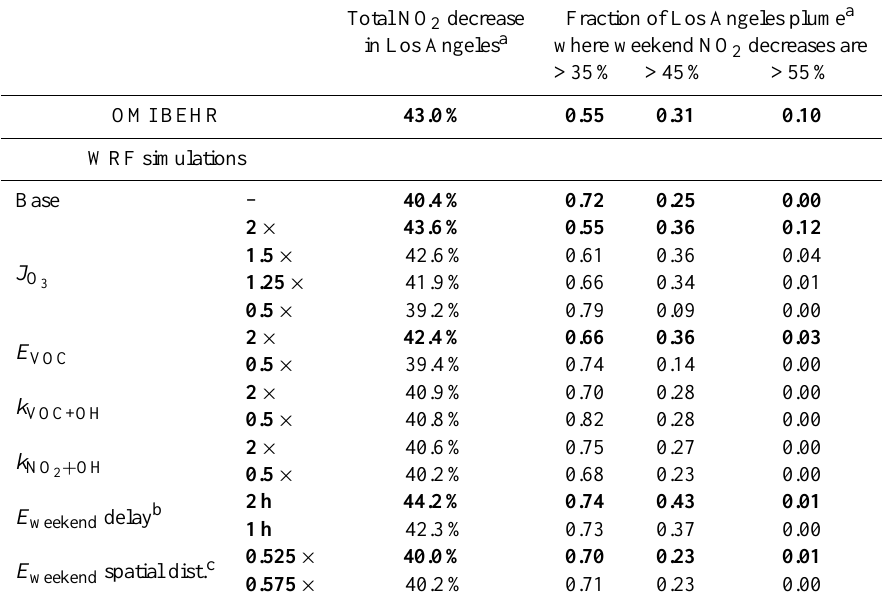
Table 1. Summary of observed and simulated weekday–weekend patterns of NO 2 column in Los Angeles. Bold-face entries denote results from simulations shown in Fig. 3. Total NO 2 decrease Fraction of Los Angeles plume a in Los Angeles a where weekend NO 2 decreases are >35% >45% >55% OMI BEHR 43.0%